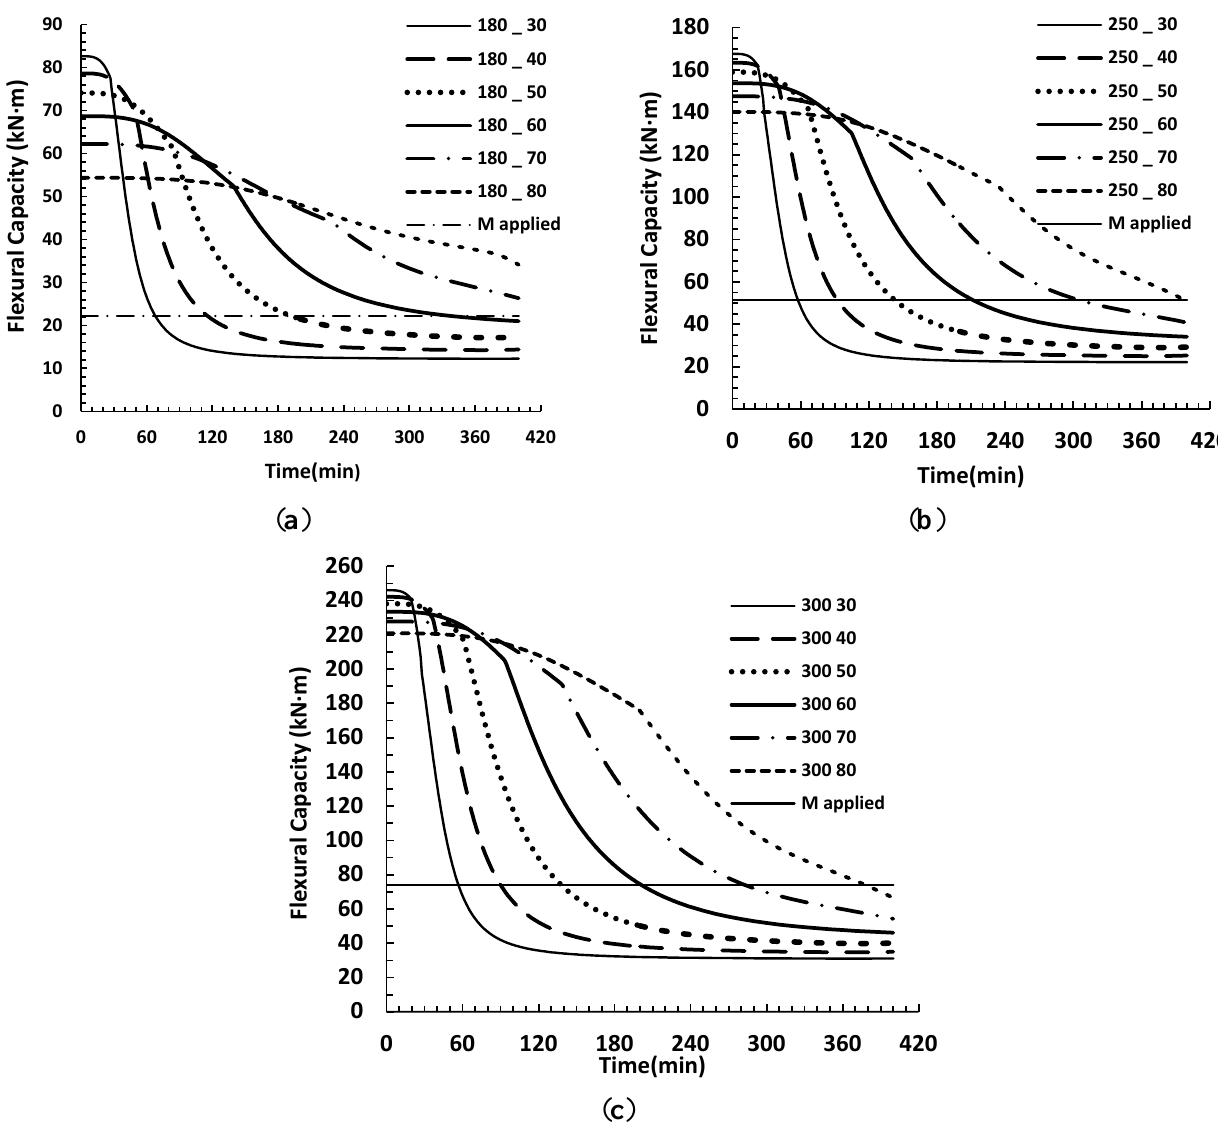
Figure 7. Moment capacities of 180 mm thick slabs with various cover depths in